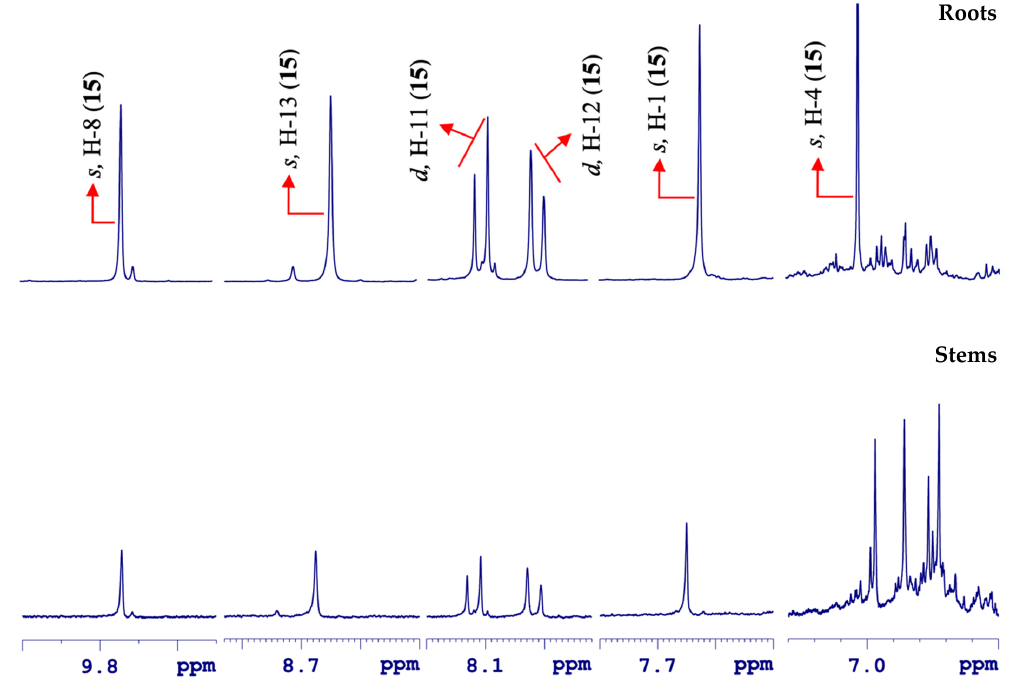
Figure 8. Comparative overview of the amplified aromatic region in the 1 H HR-MAS NMR spectra from the roots and stems parts in Berberis laurina (400 MHz, ~10 mg swollen in 40 µ L CD 3 OD). Molecules 2020 , 25 , x FOR PEER REVIEW